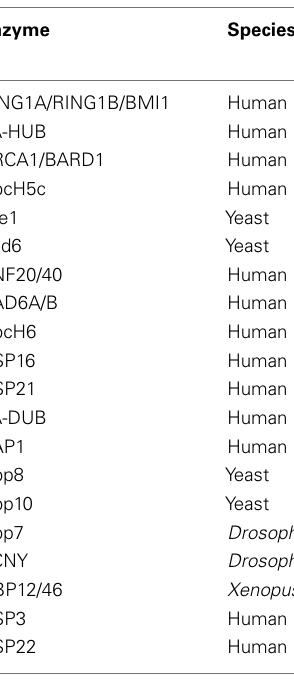
Table 1 | Functions of histone modifying enzymes for